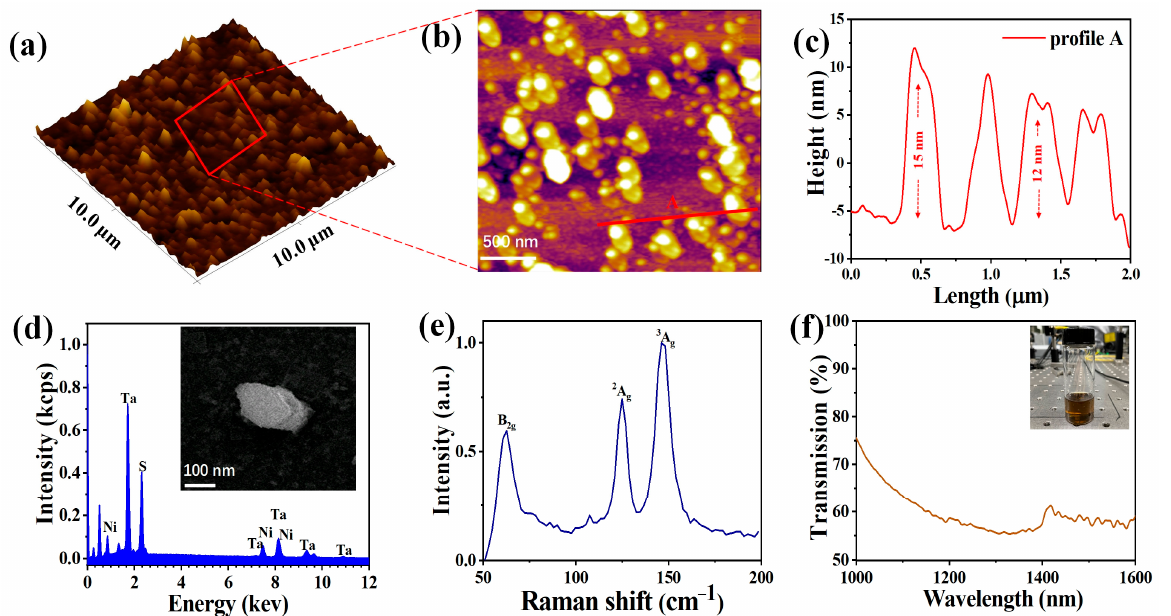
Figure 2. ( a ) 3D Morphology image of Ta 2 NiS 5 nanosheets. ( b ) 2D Morphology image of Ta 2 NiS 5 nanosheets. ( c ) Corresponding thickness distribution of Ta 2 NiS 5 nanosheets. ( d ) EDS image and SEM image (Inset). ( e ) Raman spectrum of the Ta 2 NiS 5 nanosheet. ( f ) Transmission spectrum of the Ta 2 NiS 5 nanosheets solution (IPA).